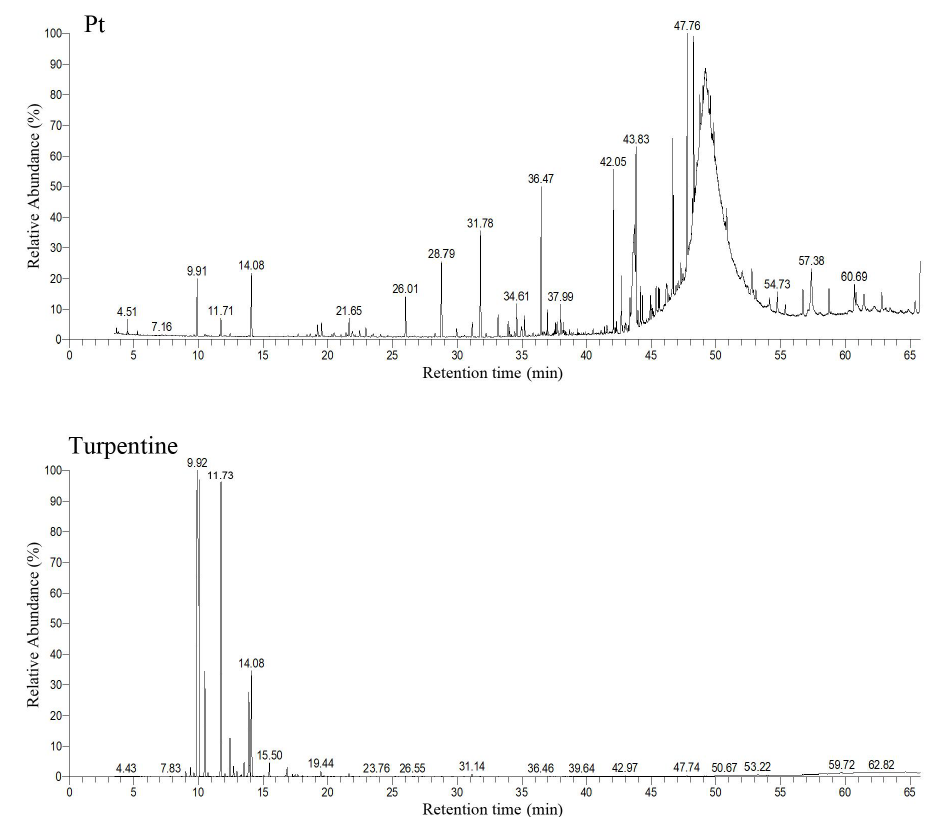
Figure 1. GC-MS chromatograms of P. armandii ( Pa ) and P. tabuliformis ( Pt ) phloem powders and the turpentine oil used in this research.